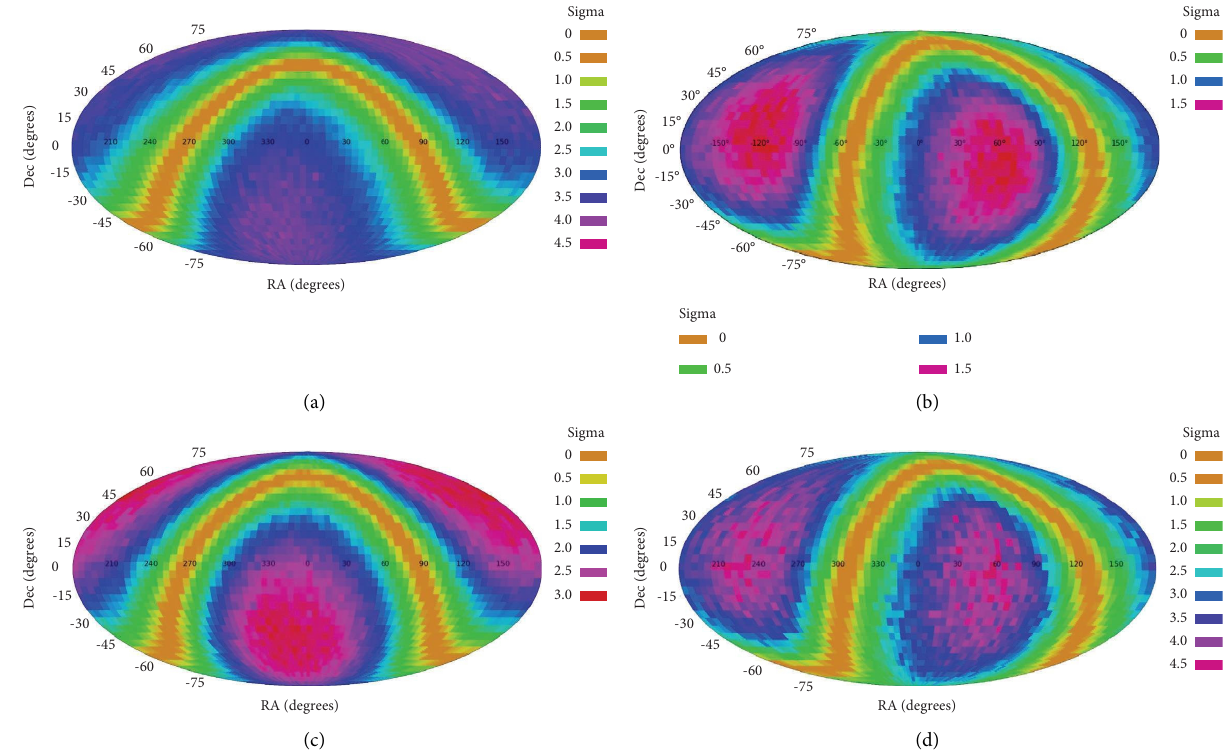
Figure 3: Previous results of dipole axes observed in previous work. (a) Figure 4 in [73] based on 77,840 SDSS galaxies [73], (b) Figure 12 in [4] based on Pan-STARRS data, (c) Figure 13 in [18] based on SDSS data, and (d) Figure 3 in [6] based data from DECam. 00.511.522.533.544.5